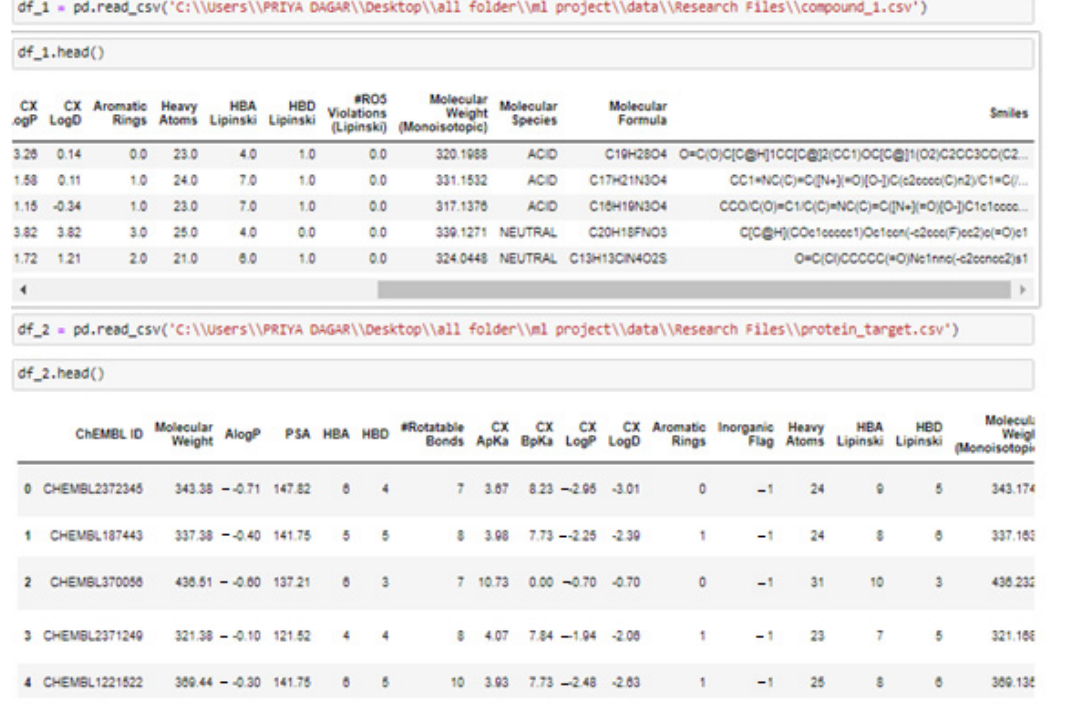
Figure 3. Dataset for training and